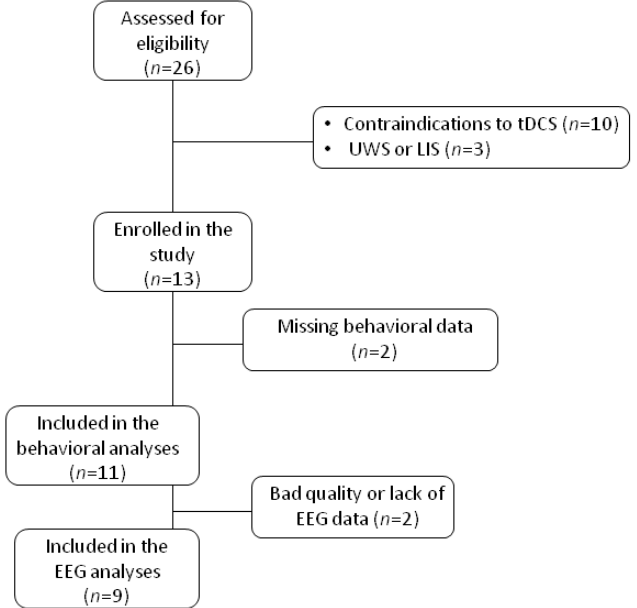
Figure 1. Study flowchart. tDCS = transcranial direct current stimulation; UWS = unresponsive wakefulness syndrome; LIS = locked-in syndrome; EEG = electroencephalography.